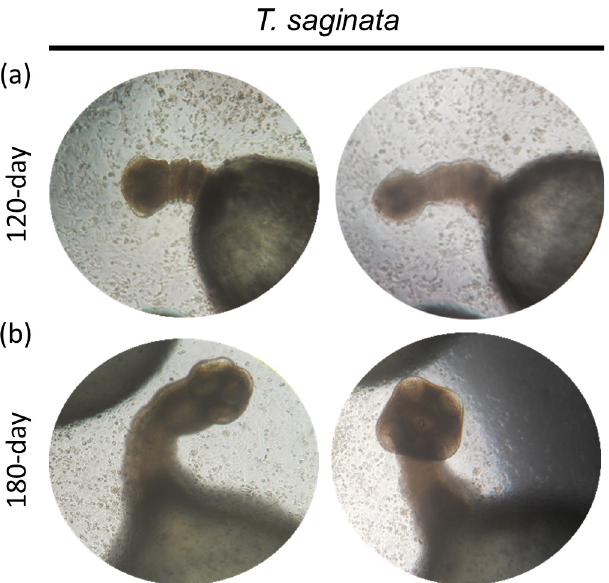
Fig 2. Light microphotography of T . saginata postoncospheral form at 120 and 180 days of culture in INT-407 cells. At 120 days of culture a pre-scolex-like structure appears (a) and at 180 days of culture, a scolex appears (b). Magnification 100x.